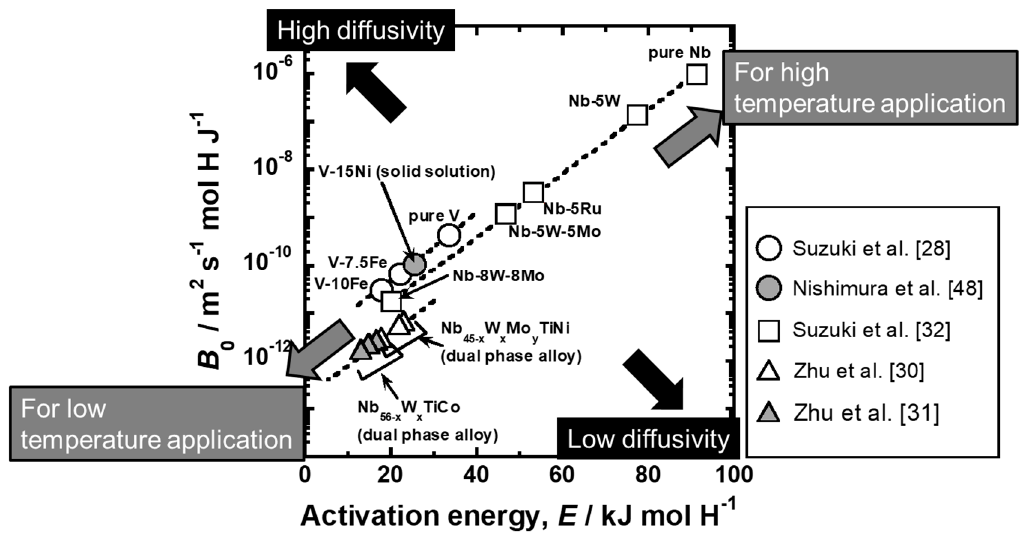
Figure 15. Relationship between the pre-exponential factor ( B 0 ) and the activation energy ( E ) for V-based solid solution alloys [28,48], Nb-based solid solution alloys [32], and Nb-based dual phase alloys [30,31].